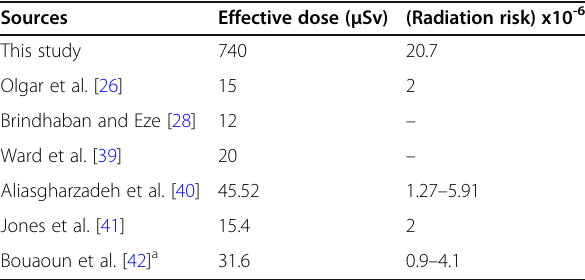
Table 9 Comparison of effective dose and radiation risk